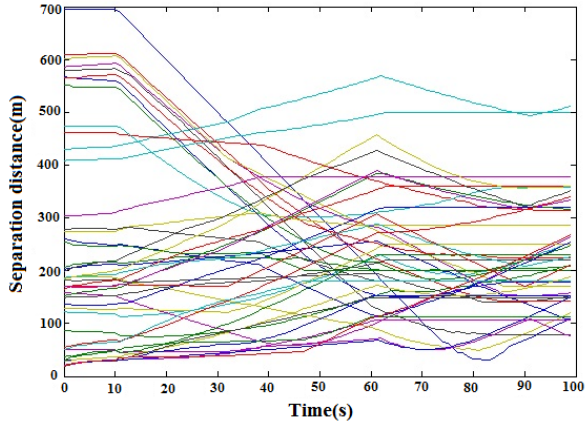
Figure 17. Case 3: Cooperative collision avoidance against temporary communication failure (normal situation): Separation distance along the horizontal direction.